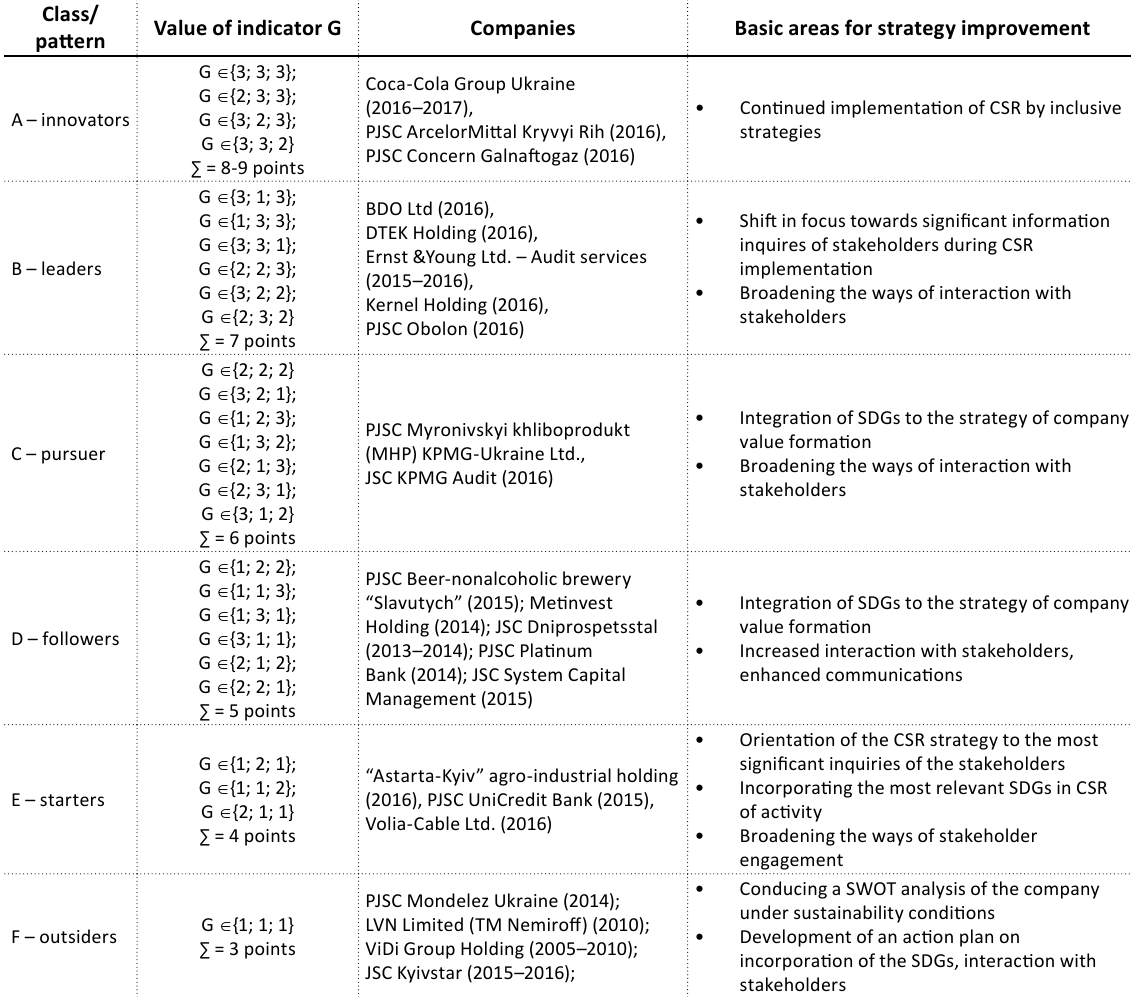
Table 2. Map of measures on the improvement of the strategies of responsible behavior by their patterns in quantitative